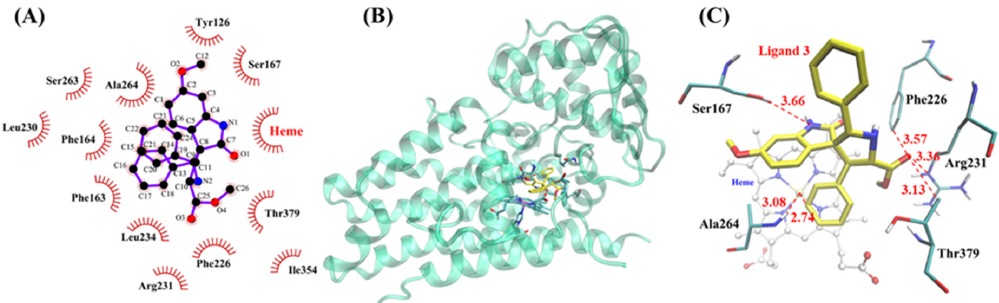
Figure 8. ( A ) Stabilization forces between inhibitor 3 and the active site of IDO1 are defined by LigPlot + . For LigPlot + analysis, hydrophobic interactions are illustrated with an “eyelash” symbol. ( B ) The overall structure of the docking results of inhibitor 3 binding to IDO1; inhibitor 3 is shown as stick models in yellow. ( C ) Top view of inhibitor 3 –IDO1 structure. Heme is shown as a ball and stick model in white. Inhibitor 3 and the key hydrophobic residues are shown as stick models in yellow and cyan. Hydrophobic interactions are shown as dotted lines.